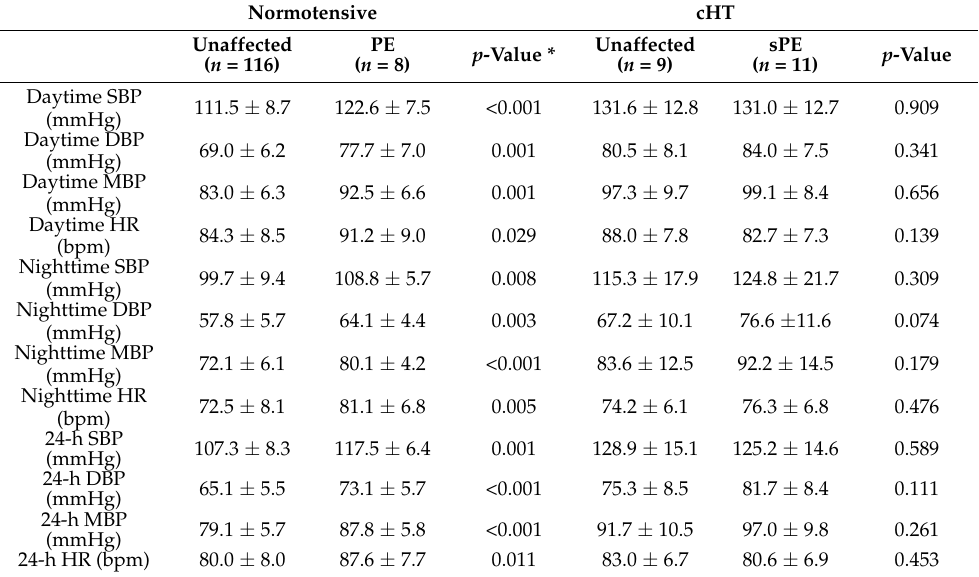
Table 4. Ambulatory blood pressure values in the first trimester in normotensive and chronic hypertensive pregnant